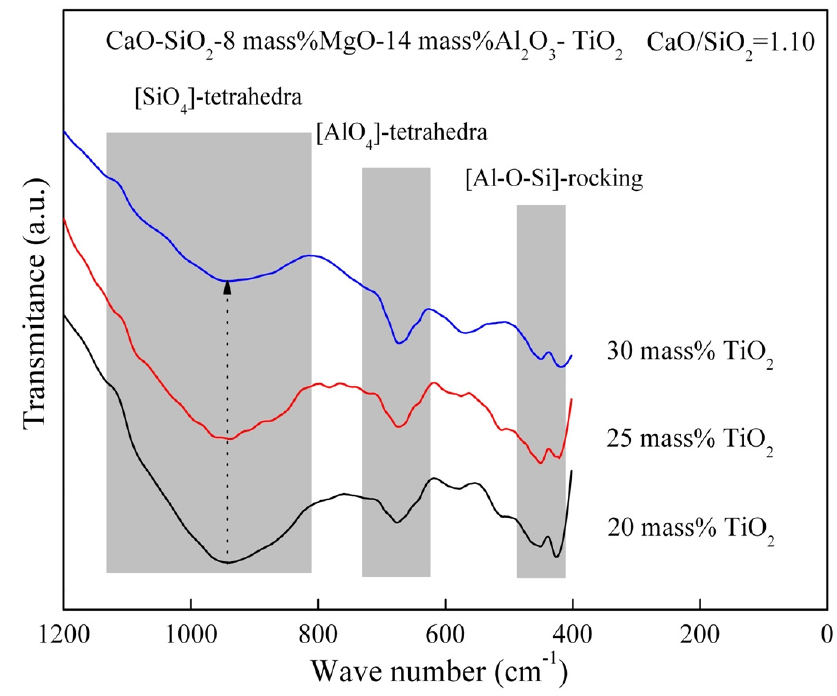
Figure 10. FT–IR transmittance spectra of the slag containing different TiO 2 content at 1773 K. The depth of the FT–IR spectra between 1200 cm − 1 and 800 cm − 1 decreases with the increase in TiO 2 content, which indicates that the network structure of [SiO 4 ]-tetrahedra becomes simpler with TiO 2 content addition. The depth of the peak representing the [Al-O-Si]-rocking is also decreased with the increase in TiO 2 content. The effect of TiO 2 content on [AlO 4 ]-tetrahedra is insignificant. According to previous study, the existent forms of TiO 2 in the slag include two types [12,31]. TiO 2 as a basic oxide provides Ti 4+ to depolymerize network structure or it as an acidic oxide forms simple network structure of TiO 44 − . In the present study, TiO 2 might be more inclined to existing as a network modifier and depolymerizes the silicate network structure. So, the viscosity decreases with TiO 2 addition.